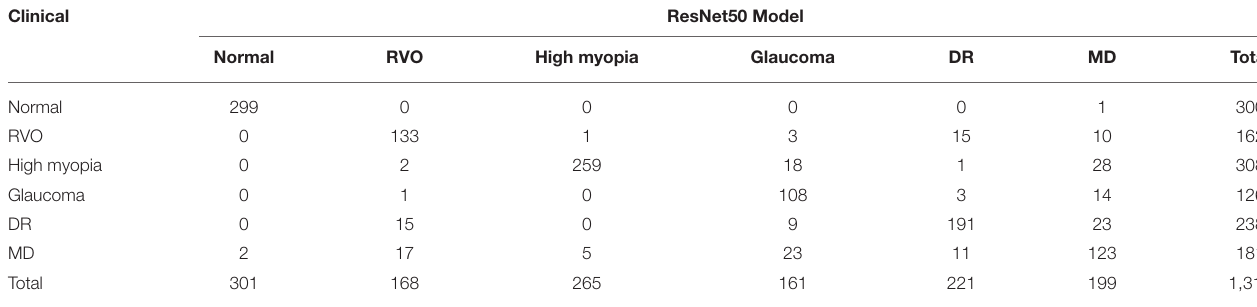
TABLE 2 | Diagnostic results of the ResNet50 model.